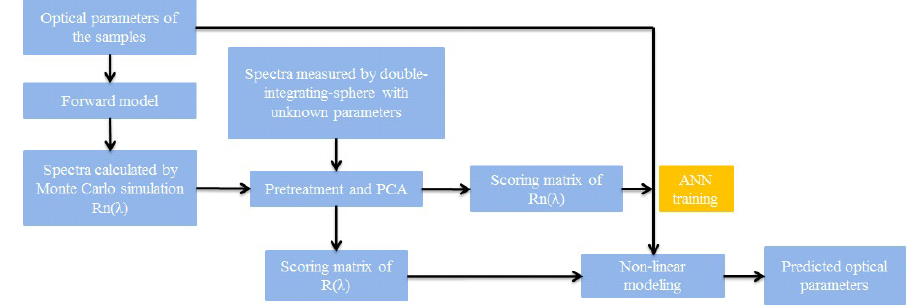
Fig. 3. Schematic of novel parameter reconstruction method using PCA þ